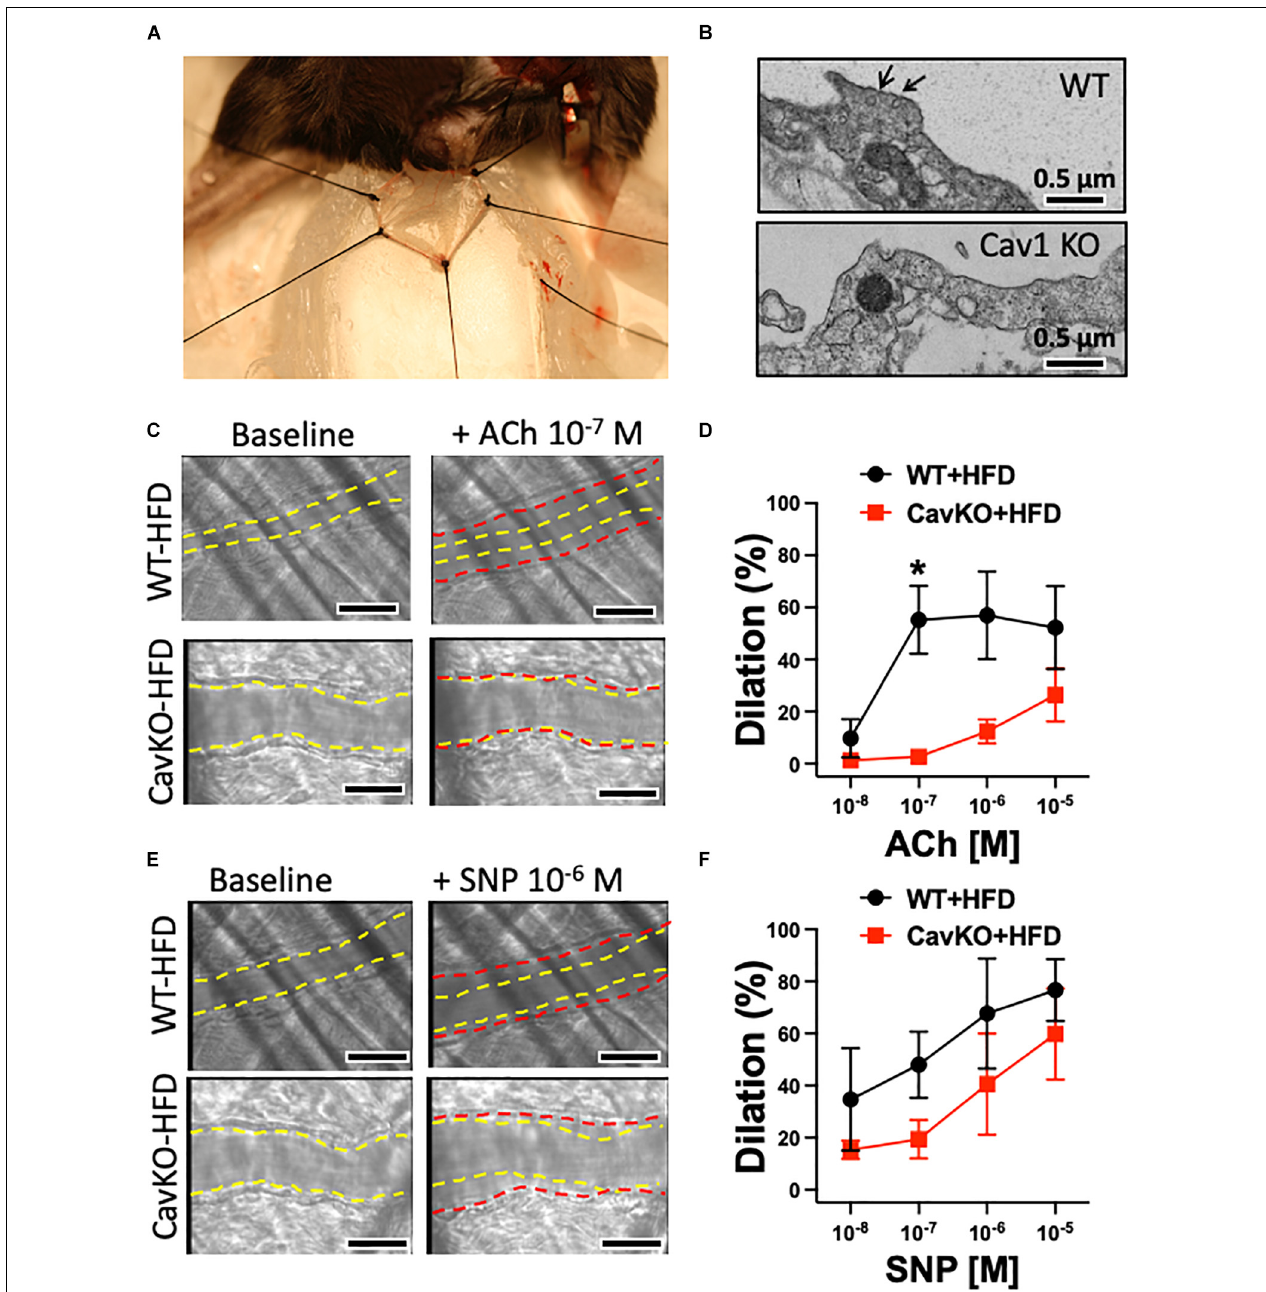
FIGURE 4 | Dilations of the cremaster muscle arterioles in HFD fed Cav-1 knockout and WT mice, in vivo . Representative photo depicts the cremaster muscle preparation used for in vivo measurements of arteriole vasodilator function in the anesthetized mouse (A) . Representative electron microscopy photographs show caveolae (black arrow) in the aorta of WT mice and the absence of caveolae in the aorta of Cav-1 KO mice (B) . Scale bar = 0.5 µ m. Representative original figures of baseline (yellow dashed line) and diameter changes (red dashed line) of cremaster muscle arterioles from HFD WT and Cav-1 KO mice in response to acetylcholine (ACh, 10 − 7 M) (C) or NO donor, sodium nitroprusside (SNP, 10 − 6 M) (E) . Scale bar = 20 µ m. Summary data of percent diameter changes of cremaster muscle arterioles from HFD WT and CavKO mice in response to acetylcholine (ACh, 10 − 8 to 10 − 5 M) (D) or NO donor, sodium nitroprusside (SNP, 10 − 8 to 10 − 6 M) (F) . n = 4 in each group, * p < 0.05 HFD CavKO vs. HFD WT